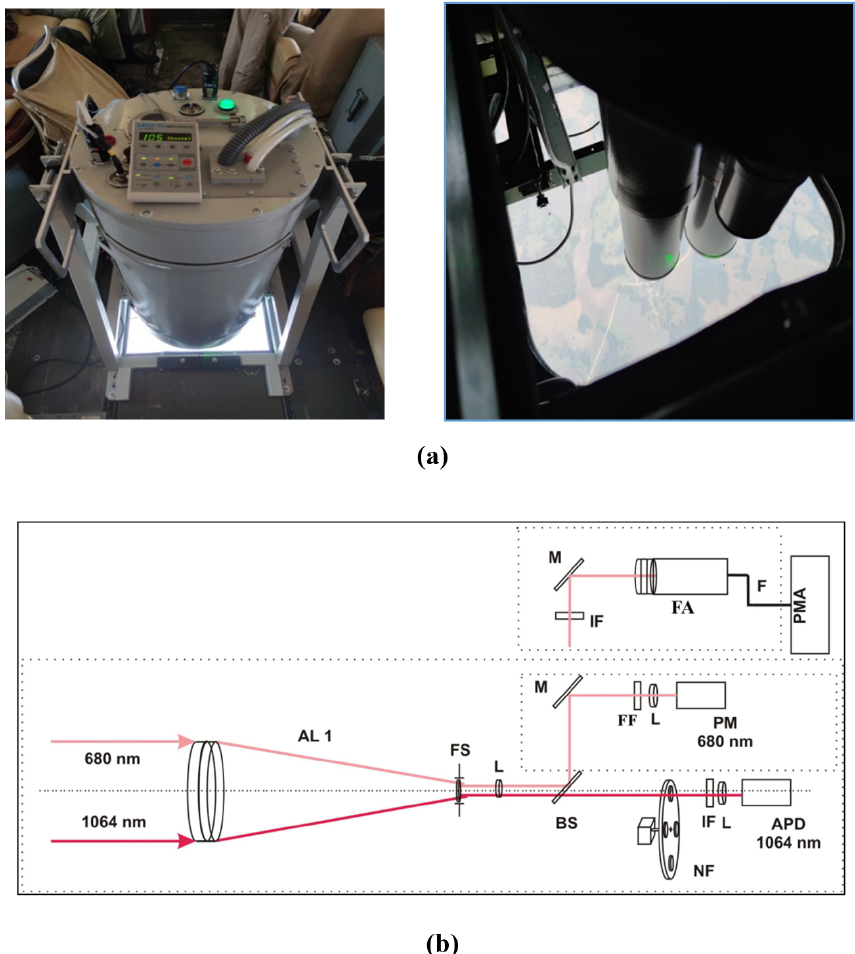
Figure 4. Photo (right) of the 680 fluorescent channel unit built in the lidar (a) and the optical arrangement of the lidar with fluorescent channels (b)